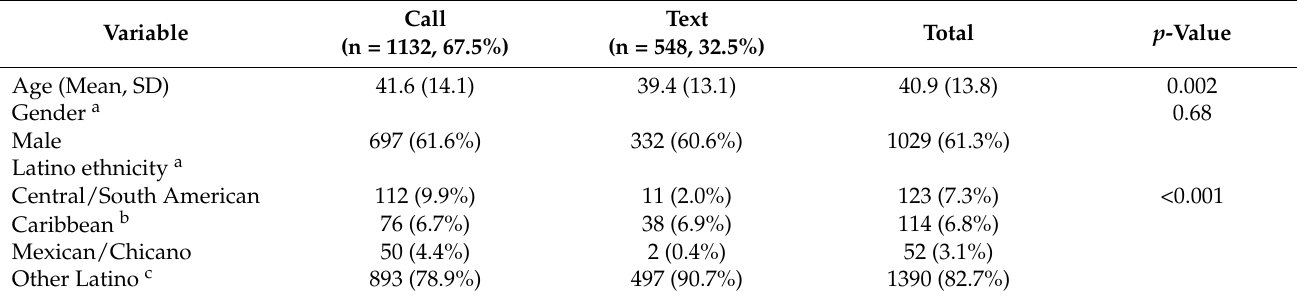
Table 1. Sociodemographic characteristics of the participants by recruitment contact method (N = 1680).